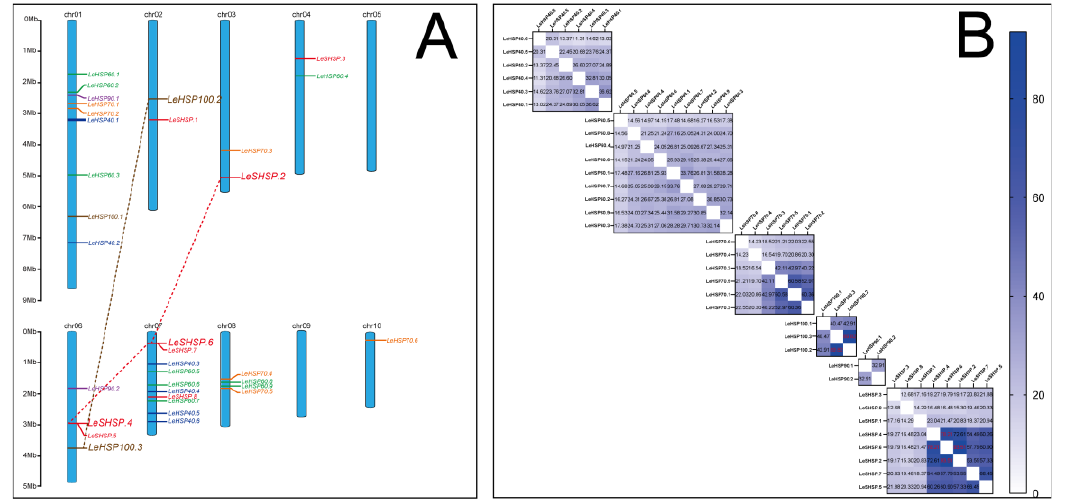
Figure 3. Chromosomal location and gene duplication of LeHSP genes. ( A ) 34 LeHSP genes were mapped on 8 chromosomes. Chromosome numbers are indicated at the top of each bar. The gene names are labelled in different colors. The scale on the left is in megabases. ( B ) Relationship of LeHSPs with one another in different subfamilies. The white color represents shared zero percent identity, and deep blue indicates shared 100% identity.